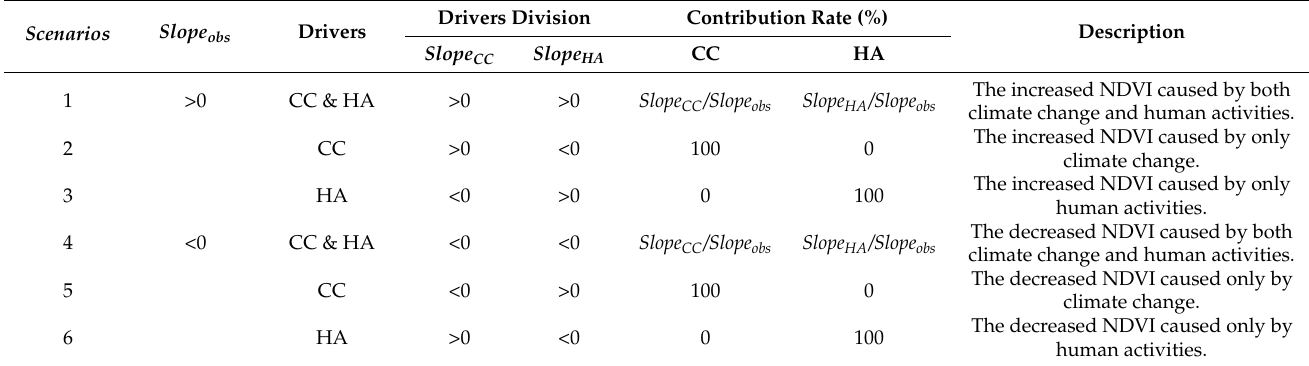
Table 1. Scenarios for the relative contribution of climatic and anthropogenic impacts on vegetation